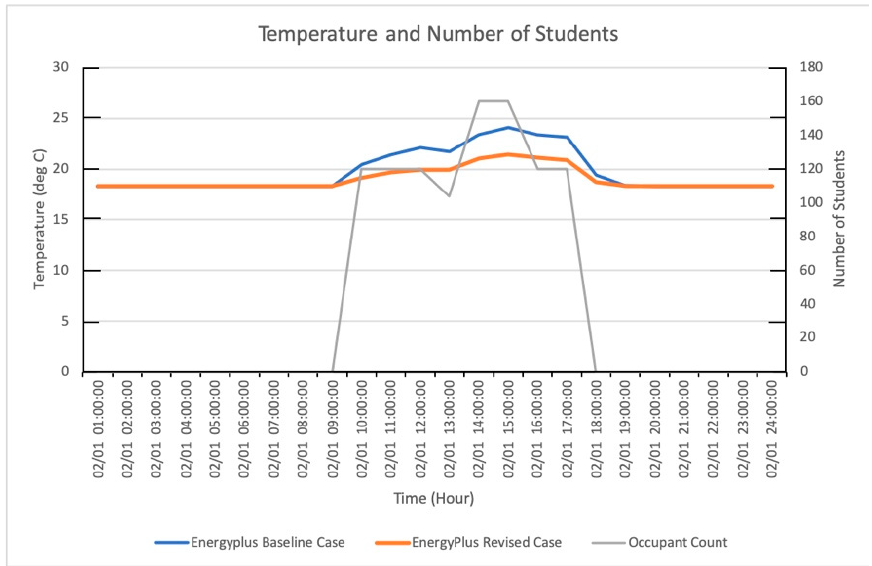
Figure 11. EnergyPlus temperature results of a day, showing a reduction in indoor air temperature.